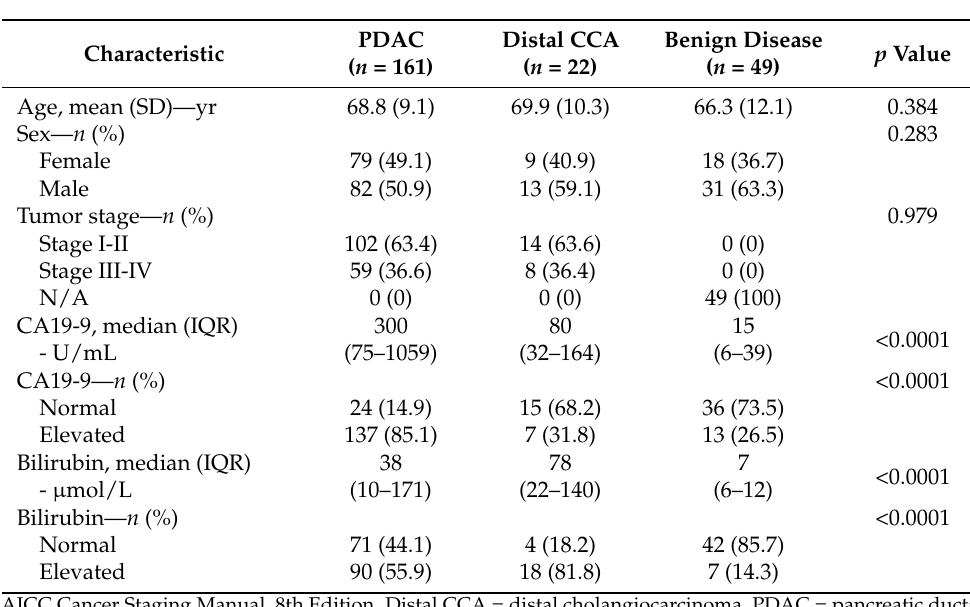
Table 3. Baseline Characteristics of the Included Patients for Calculation of the CA19-9 and Bilirubin Ratio.